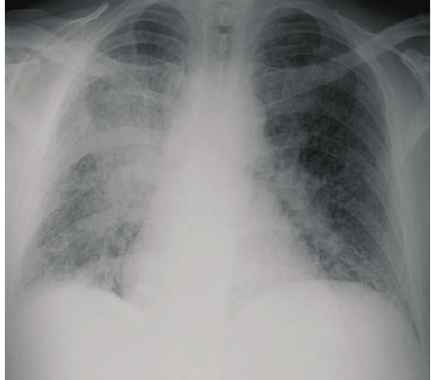
Figure 3: CXR showing progression of right lower lobe lesion and development of bilateral miliary nodules. There was 2-week time interval between this CXR and CXR shown in Figure